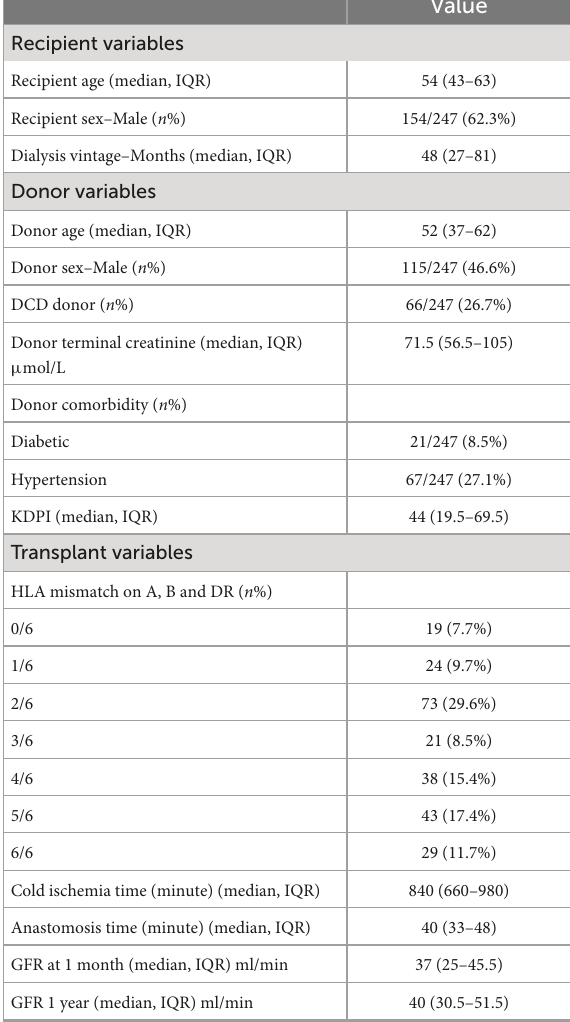
TABLE 1 Summary of the recipient, donor, and transplant variables in the study cohort ( n = 247).